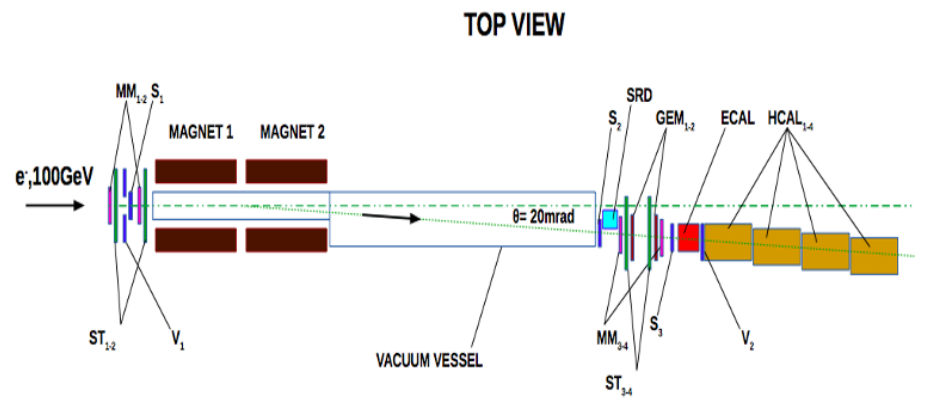
Figure 1. Schematic illustration of the setup to search for A (cid:48) → in v isible decays of the bremsstrahlung A (cid:48) s produced in the reaction eZ → eZA (cid:48) of 100 GeV e − incident on the active ECAL